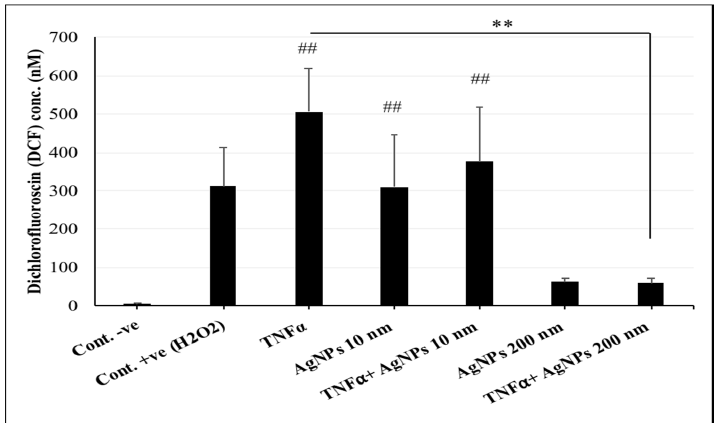
Figure 3. Reactive oxygen species (ROS) production in NCI-H292 cells. Cells were exposed to tumor necrosis factor- α (TNF α ) (20 ng/mL) and AgNPs 10 nm (100 µg/mL) or AgNPs 200 nm (100 µg/mL) separately and together for 24 h. ROS production is expressed by the produced DCF amount. The results are shown as means ± SD, n ≥ 3, for each group; ## and ** indicate P < 0.01. ## represents a significant increase compared to the Control -ve group, ** represents a significant decrease compared to the TNF α -exposed group. Cont. -ve are the non-treated cells and Cont. +ve are the cells exposed to H2O2 to induce ROS